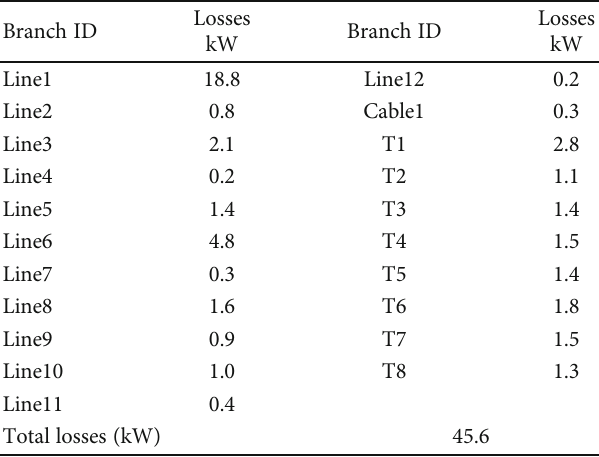
Table 6: Branch losses for Case